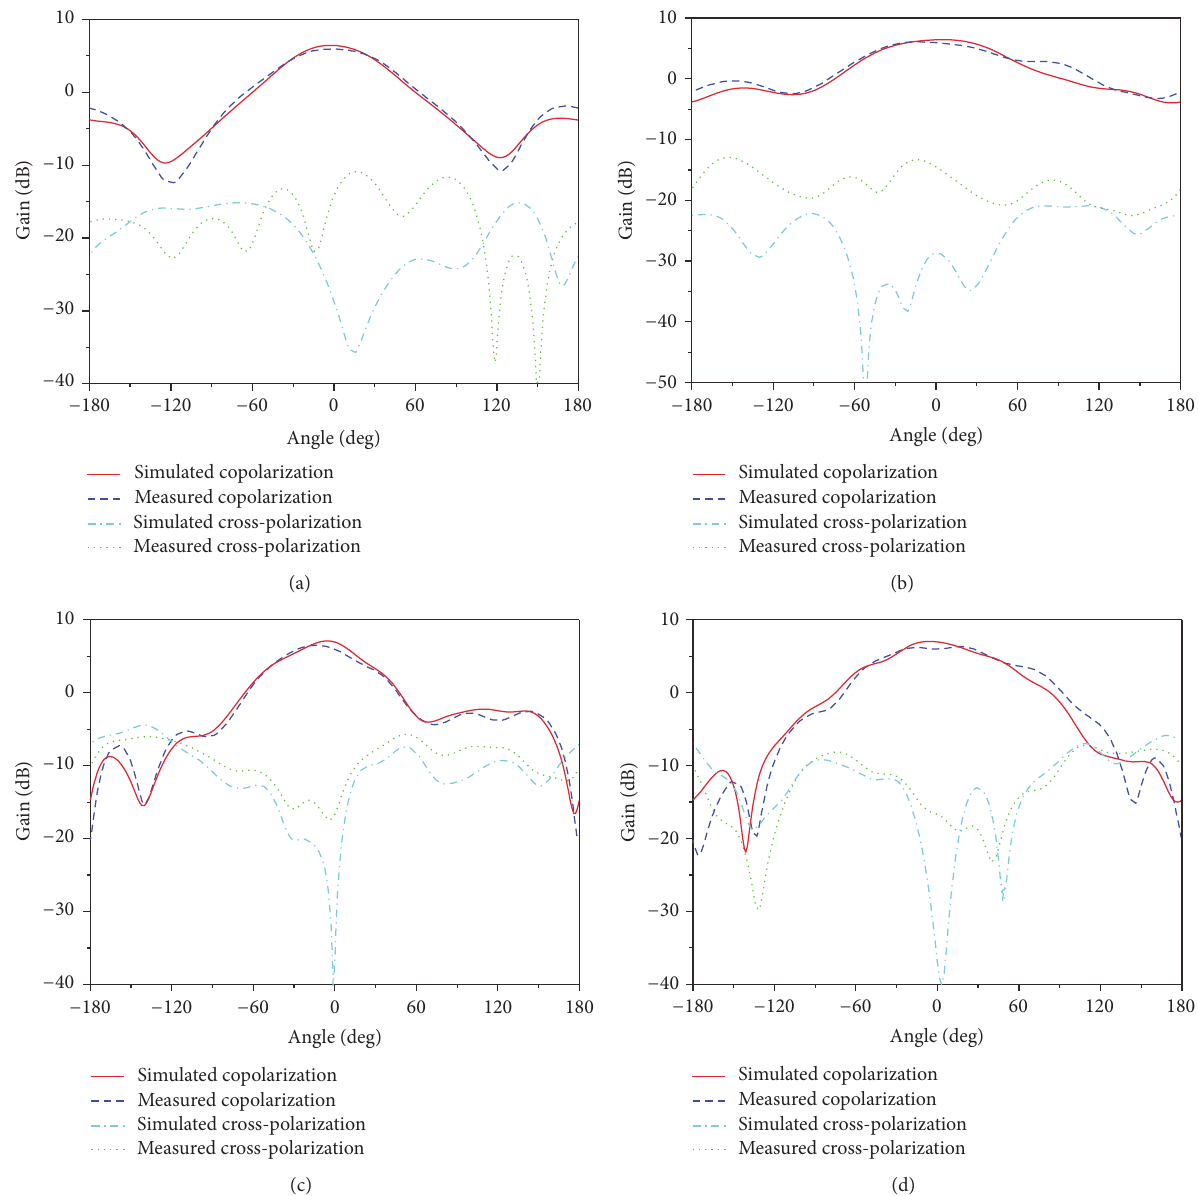
Figure 8: Radiation patterns of the proposed dual-band antenna. (a) E-plane at 3.5 GHz; (b) H-plane at 3.5 GHz; (c) E-plane at 5.25 GHz; (d) H-plane at 5.25